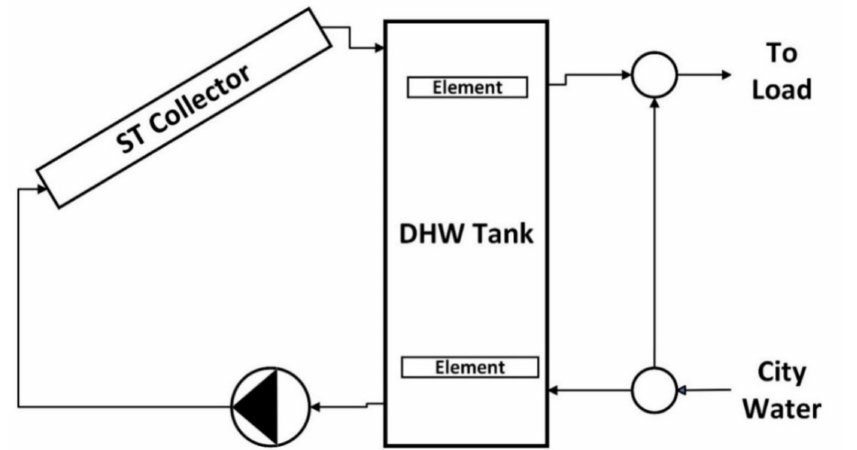
Figure 7. Schematic of conventional single-tank ST DHW